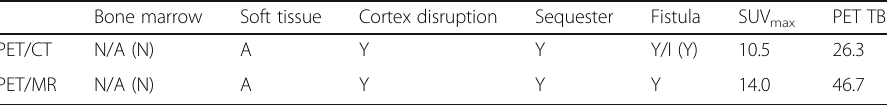
Table 4 Consensus results for patient